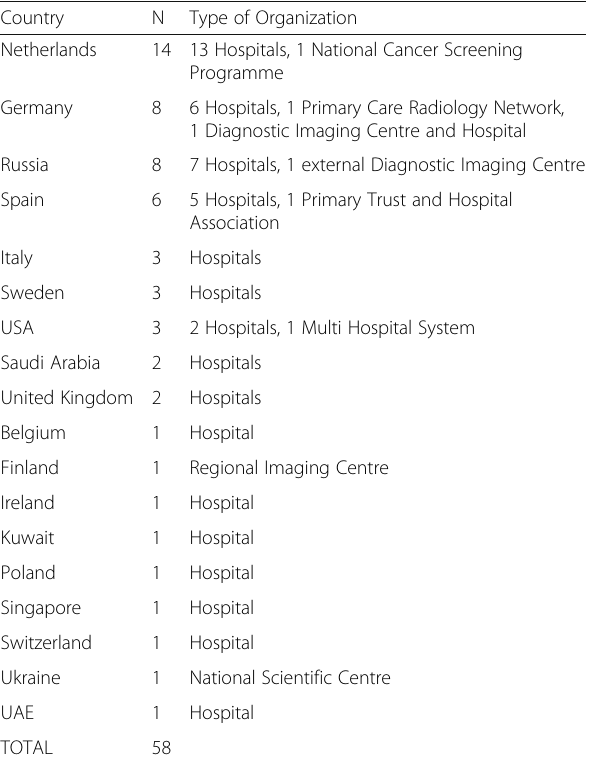
Table 1 Countries with the number of their participating